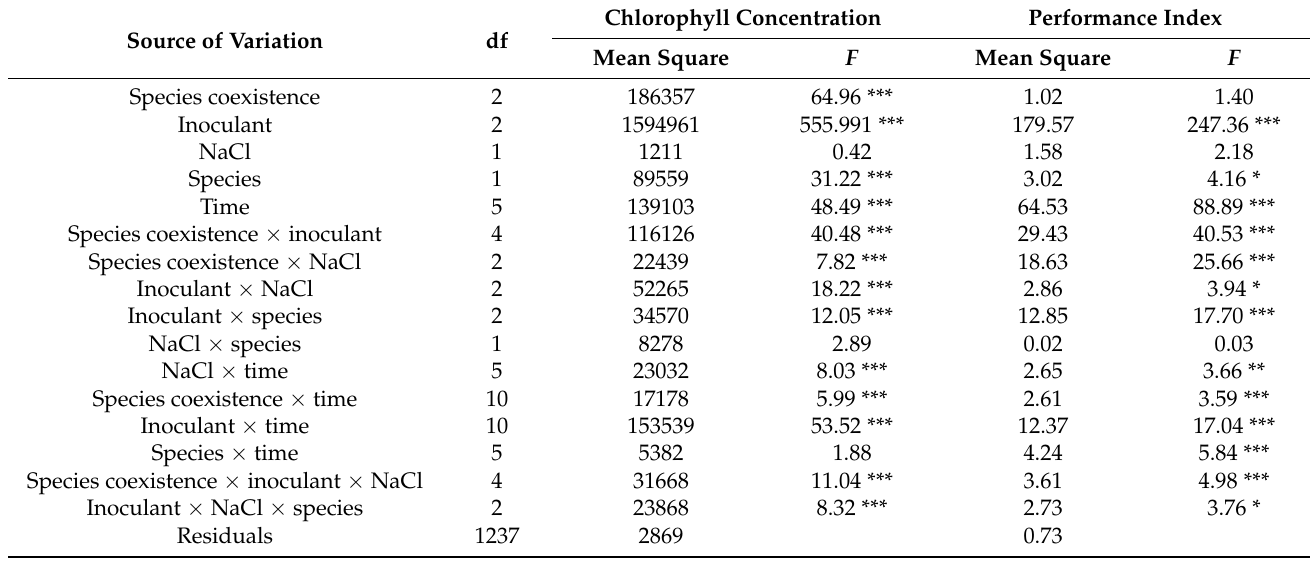
Table 9. ANOVA analysis of leaf chlorophyll concentration and Performance